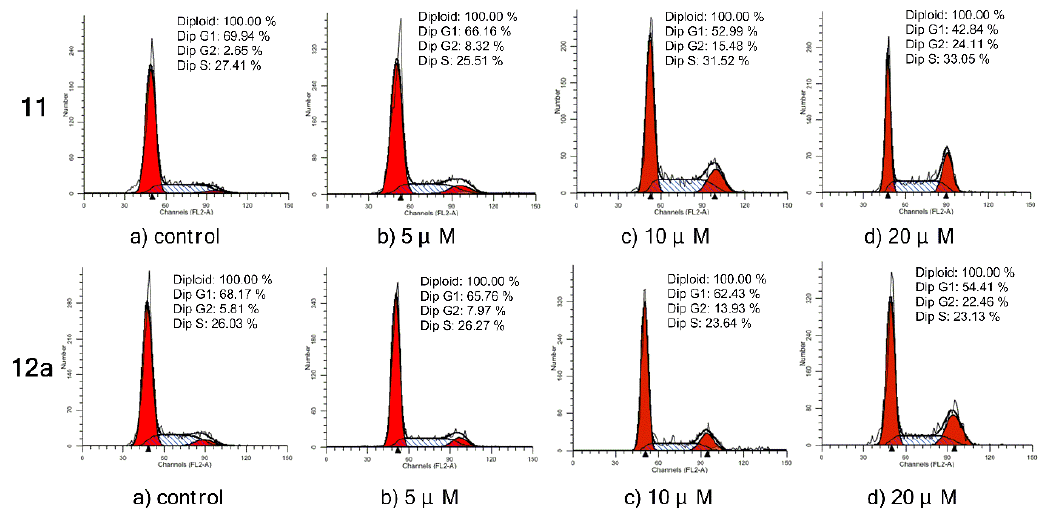
Figure 4. Inhibition of cell cycle progress on MCF-7 cells treated with compound 11/12a for 72 h. Cells were fixed with ethanol and stained with propidium iodide. Cell cycle distribution was analyzed by a flow cytometry.